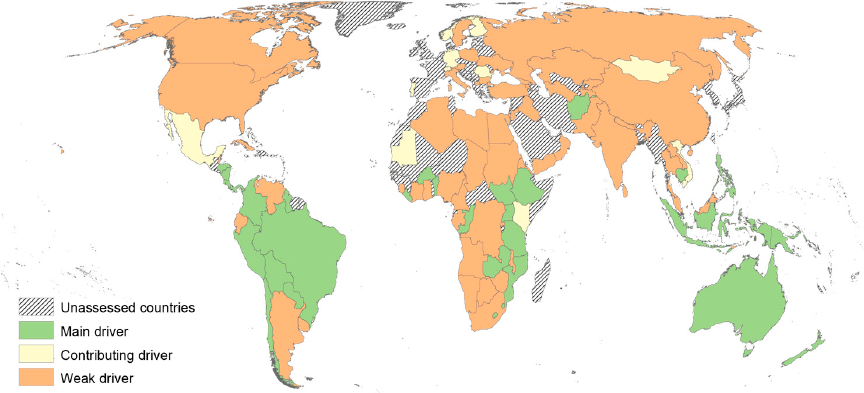
Figure 3. Legal recognition of customary tenure as a driver of recognition of community water rights.